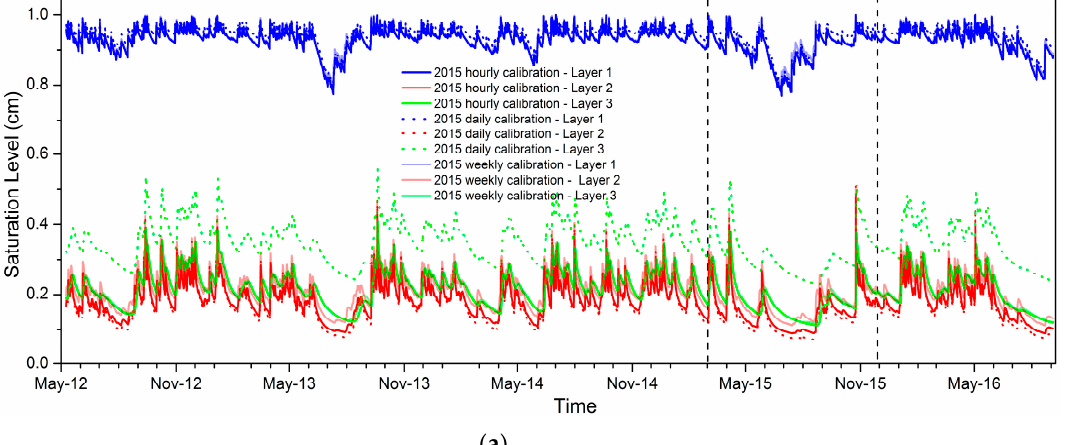
Figure 7. Cont. Figure 7. Cont.